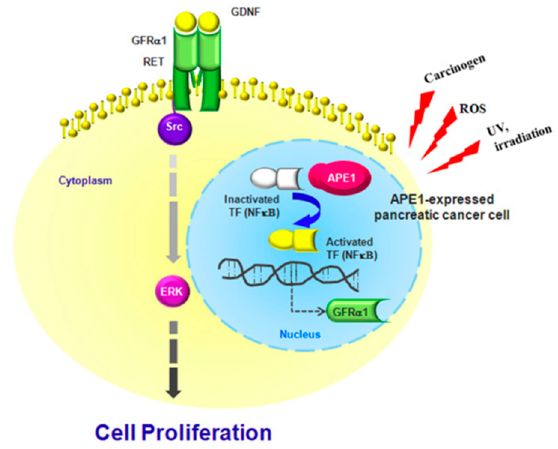
Figure 5. Schematic model of APE1-induced pancreatic cancer cell proliferation. APE1-mediated regulation of GFR α 1 expression leads to Src / ERK phosphorylation, which promotes GDNF-dependent pancreatic cancer cell proliferation.